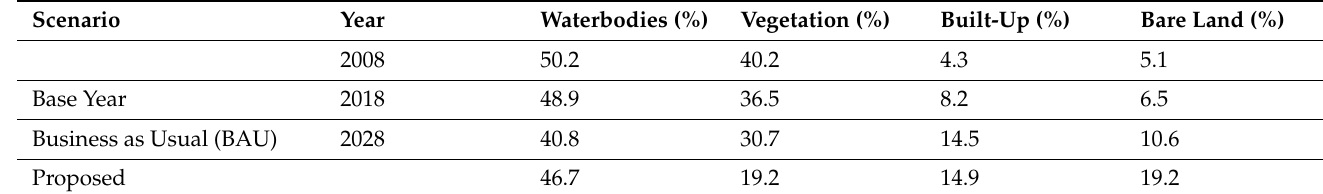
Table 3. Percentage of LULC change in different LULC